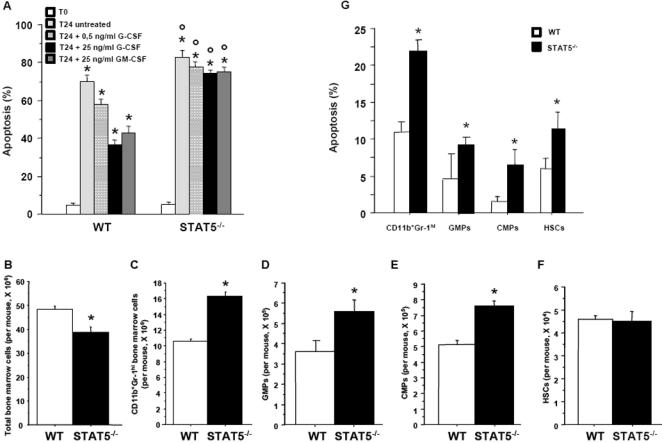
Increased granulopoiesis in STAT5−/− mice.(A) Apoptosis of peripheral neutrophils. MACS-purified blood peripheral neutrophils from wild-type (WT) and STAT5−/− mice were cultured for 24 hr in the absence or presence of 0.5 or 25 ng/ml G-CSF or 25 ng/ml GM-CSF. Freshly purified (T0) and 24-hr cultured (T24) neutrophils were assayed for apoptosis using dual color annexin-V-FITC/propidium iodide staining and flow cytometry analyses. *, significantly different from T0 values with P<0.05. °, significantly different from WT values with P<0.05. (B) Bone marrow was harvested from both hind limbs of either WT or STAT5−/− mice, and cell counts were determined after red blood cell lysis. (C–F) Mature marrow neutrophils (CD11c+Gr-1hi cells), GMPs (Lin−Sca-1−IL-7Rα−c-kit+CD34+FcγR+ cells), CMPs (Sca-1−IL-7Rα−c-kit+CD34+FcγRlow cells), and HSCs (Lin−Sca-1hiIL-7Rα−c-kithi) from the bone marrow of control and mutant mice were counted by flow cytometry. Absolute values were generated by multiplying gated percentages by total cell numbers. (G) Freshly FACS-purified marrow neutrophils, GMPs, CMPs, and HSCs were assayed for apoptosis using trypan blue exclusion. (B–G) *, significantly different from WT values with P<0.05.